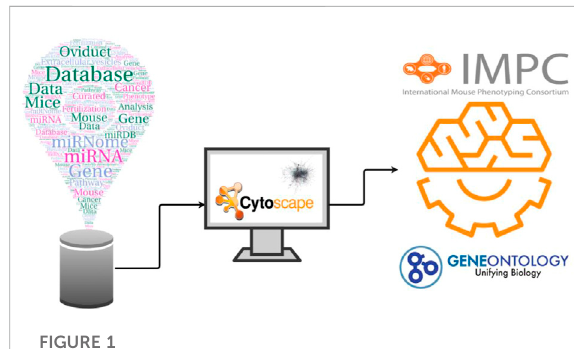
FIGURE 1 Experimental design. The fi gure illustrates the steps followed during the development of the work. 1) we collected the oviductal miRNA from the literature and we obtained from the miRDB